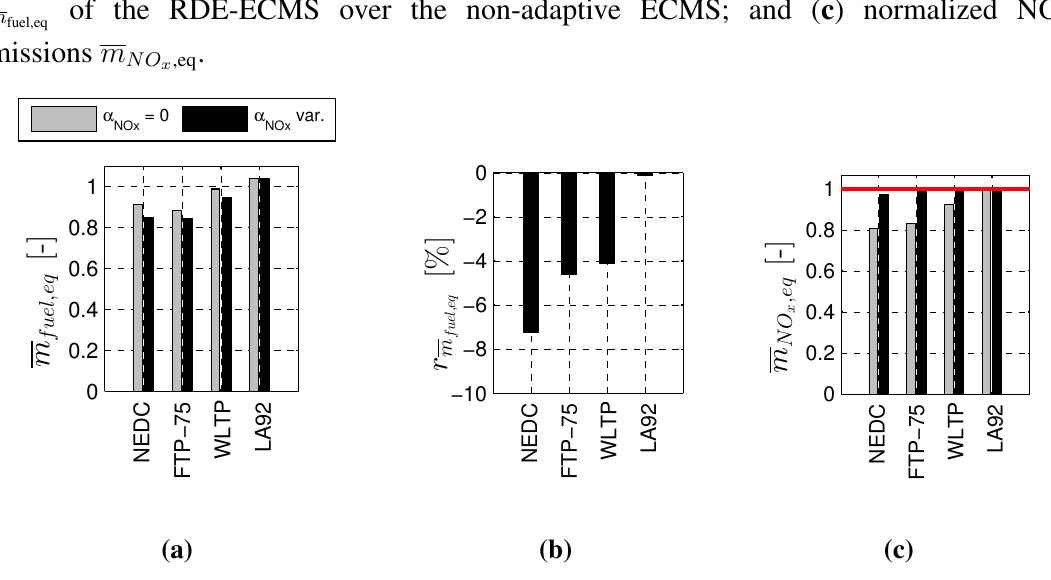
Figure 9. Comparison of the results obtained with the non-adaptive equivalent consumption minimization strategy (ECMS) (“ α = 0”) and the real driving emissions (RDE)-ECMS NO x (“ α NO x